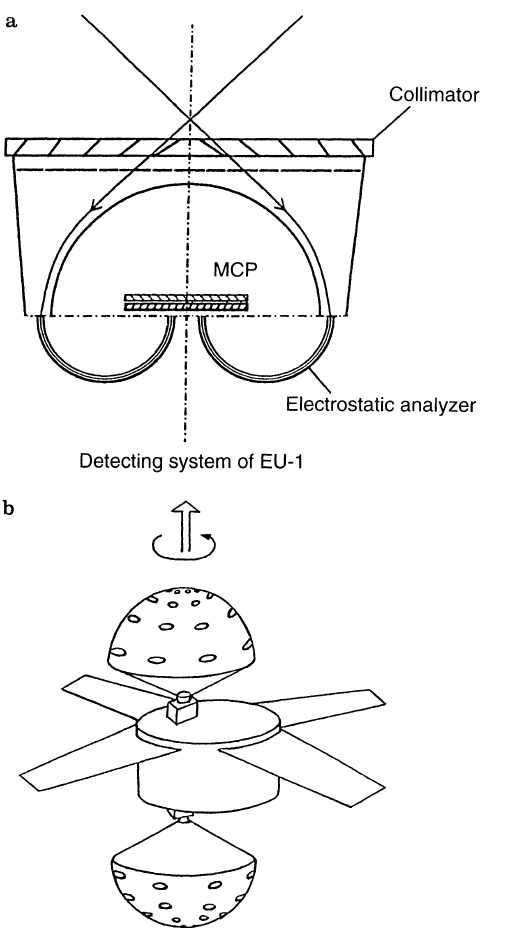
Fig. 2. a A schematic view of EU-1 analyzer. Sensor head consists of a toroidal electrostatic analyzer, channel electron multiplier MCP, followed by eight-sectored anode, electrostatic scanner consisting of central spherical electrode and grid-covered conic electrode, and sunshade baffle (collimator). b Sketch showing the viewing directions of two sensor heads of an instrument installed on rotating spacecraft. Sun direction is indicated by